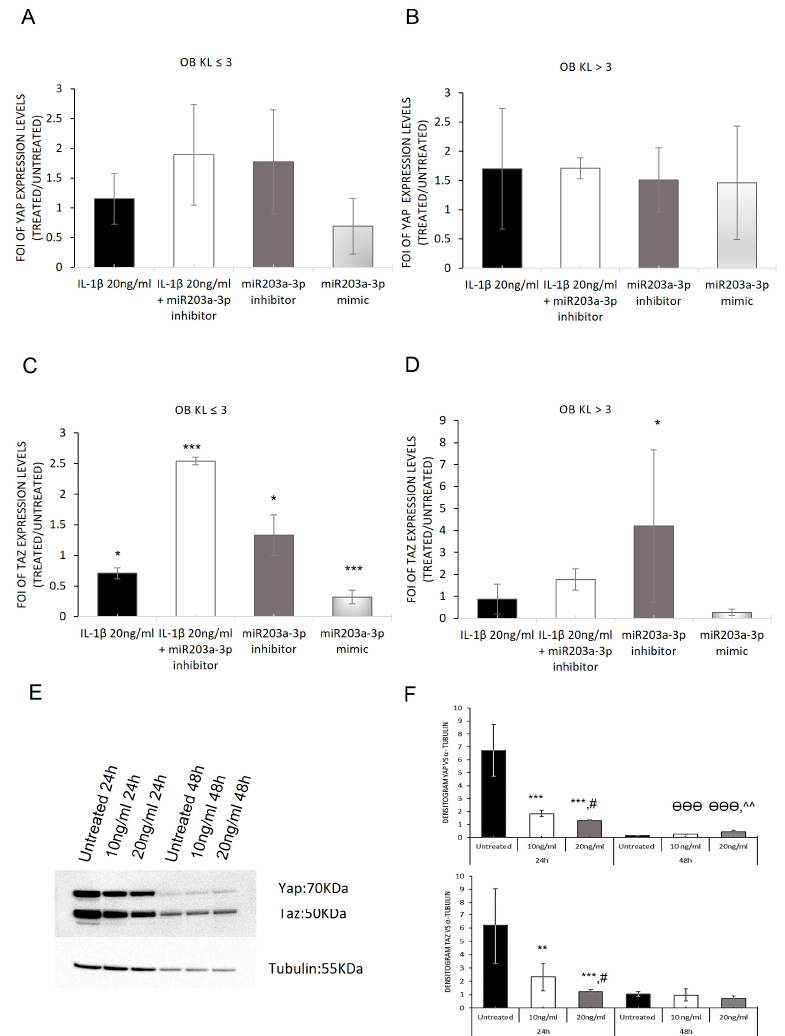
Figure 8. Modulation of YAP and TAZ: from gain and loss of function study to hMSCs treated with IL-1 β . qRT-PCR analysis of YAP/TAZ mRNA expression OB-OA-derived KL ≤ 3 ( A , C ) and KL > 3 ( B , D ) groups treated with IL-1 β or miR203a-3p inhibitor or miR203a-3p mimic or after co- treatments with IL-1 β and miR203a-3p inhibitor. Data are expressed as fold of induction (FOI) in gene expression (2 − ∆∆ Ct ) occurring in treated vs. scrambled untreated groups (mean ± SD, n = 4). Western blot and densitogram analyses of YAP and TAZ on hMSCs treated with IL-1 β ( E , F ). One-way ANOVA (YAP, KL ≤ 3: F = 2.77, NS; KL > 3: F = 0.71, NS; TAZ, KL ≤ 3: F = 107.63, p < 0.0005; KL > 3: F = 7.78, p = 0.001); multiple comparisons (one symbol, p < 0.05; two symbols, p < 0.005; three symbols, p < 0.0005) versus: *, untreated 24 h; θ untreated 48 h; # IL-1 β 10 ng/mL 24 h; ˆ, IL-1 β 10 ng/mL 48